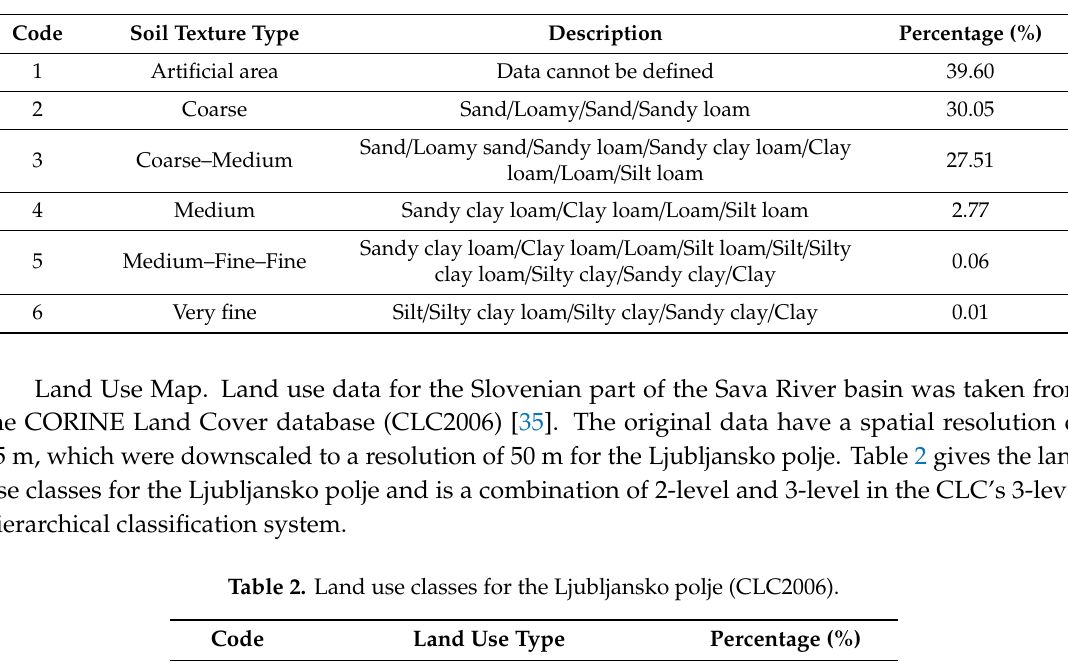
Table 1. Soil texture classes for the Ljubljansko polje (TIS / ICPVO).